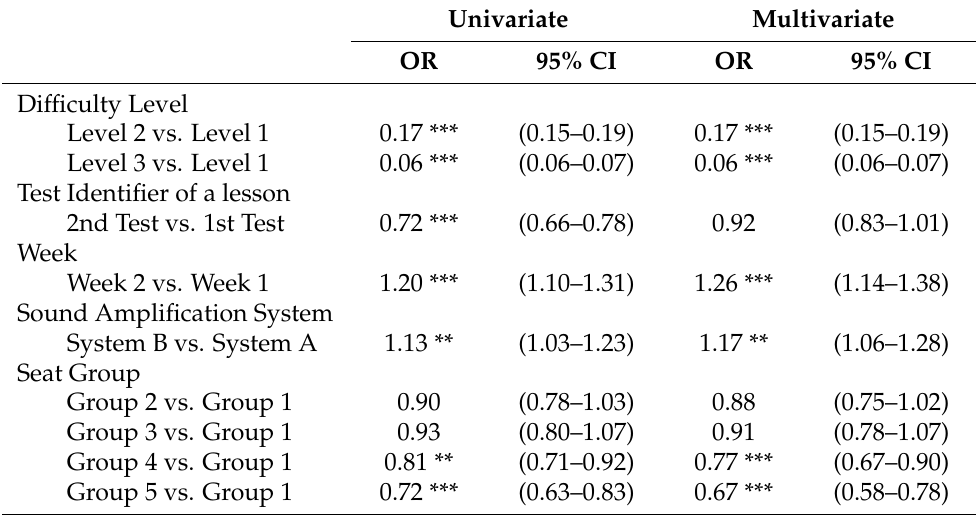
Table 8. Logistic Regression: sub analysis 1 (without Level 4 data).